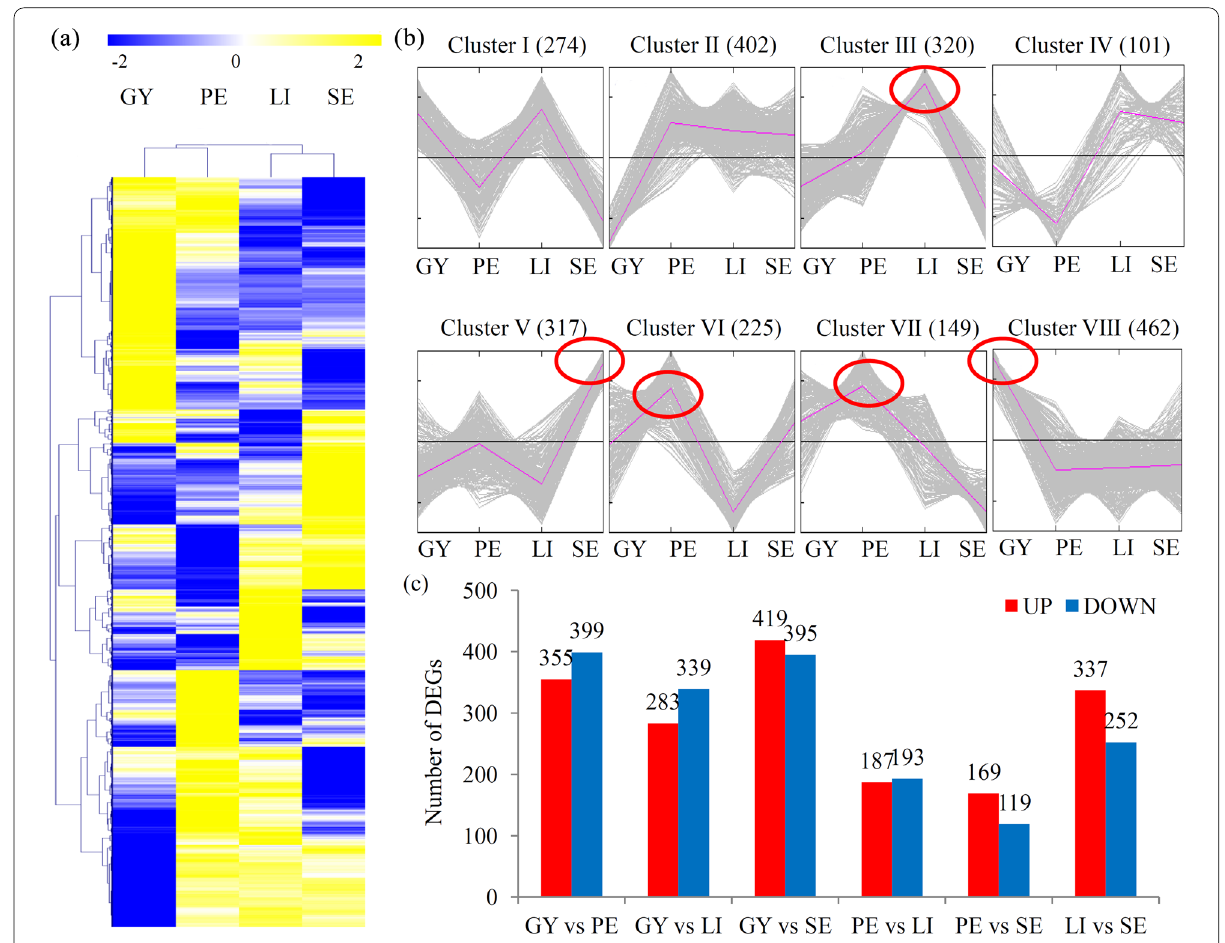
Fig. 2 Analysis of differentially expressed proteins (DEPs) among the four floral organs. a A heatmap of the abundance of proteins in the four floral organs ( N 2). The heatmap scale ranges from 2 to 2 on a log 2 scale. b – l MeV cluster analysis showed the numbers of floral organ-specific = − + expressed proteins. The red oval indicated the number of organ specific expressed proteins. j The number of DEPs in different comparisons, including the GY vs. PE, GY vs. LI, GY vs. SE, PE vs. LI, PE vs. SE, LI vs. SE